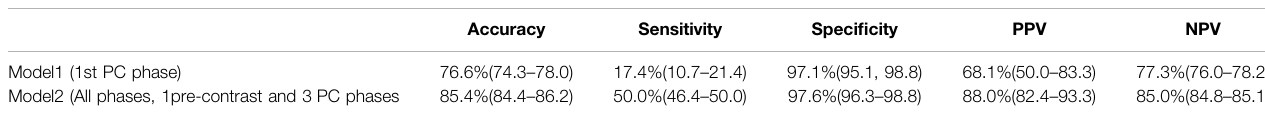
TABLE 3 | Summary of radiomics model1 and model2